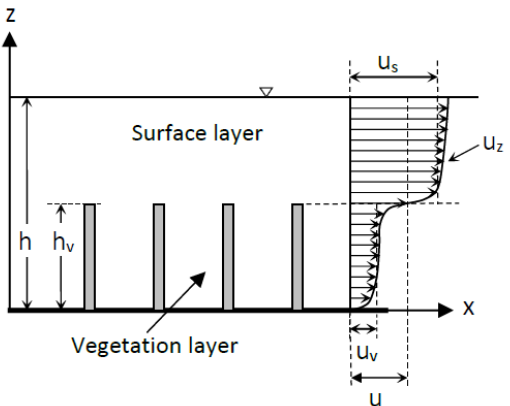
Figure 5. Side view of submerged vegetation and velocity profile.